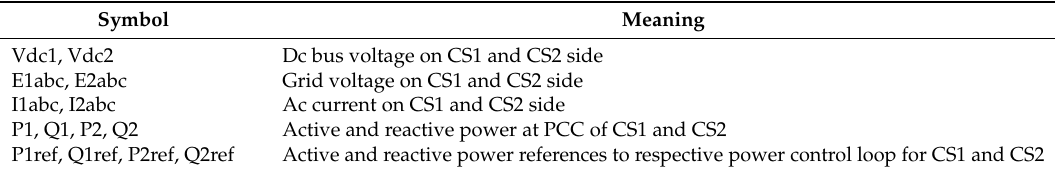
Table 2. Symbols used in the simulation results and their meanings.